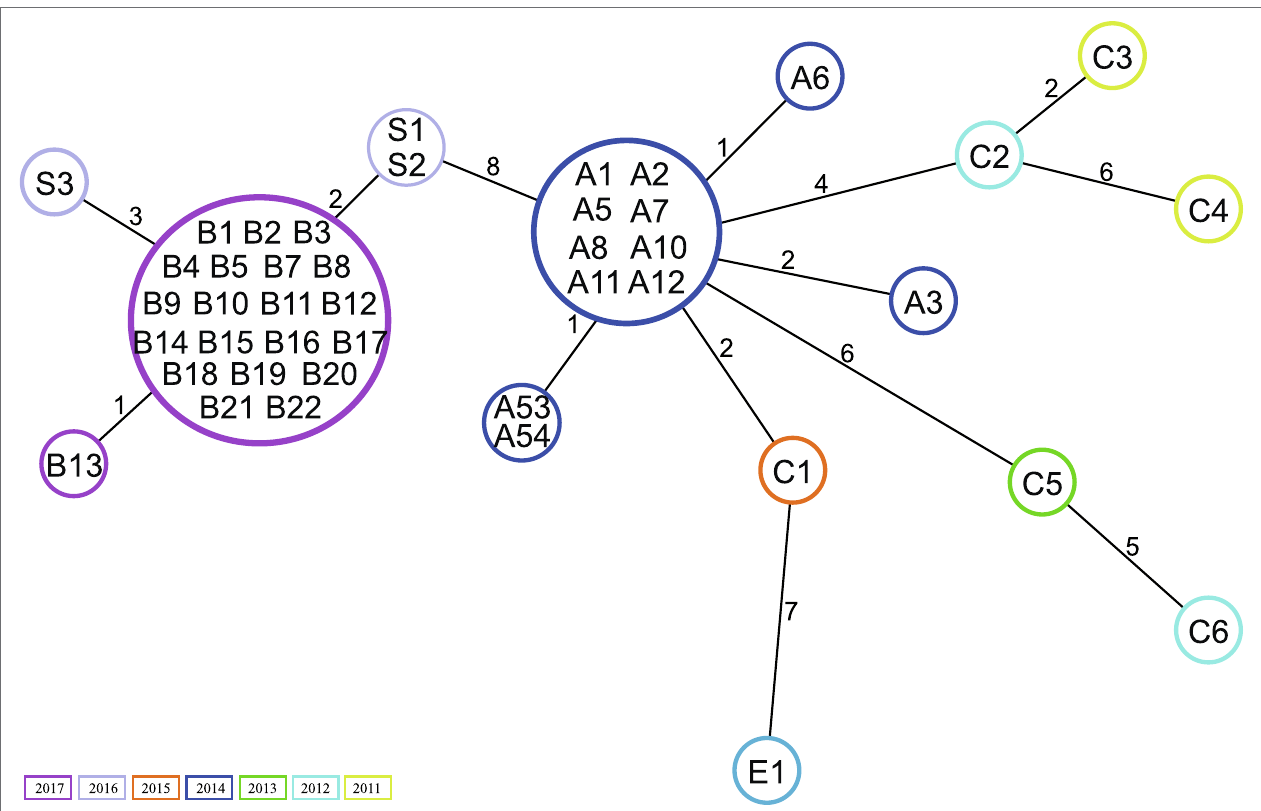
FIGURE 1 | Minimum spanning tree based on core genome Multilocus sequence typing (cgMLST; 1,423 target genes). Numbers within the circle indicate the isolates. The numbers next to the lines correspond to allele differences between the isolates. Isolates are coloured by year of